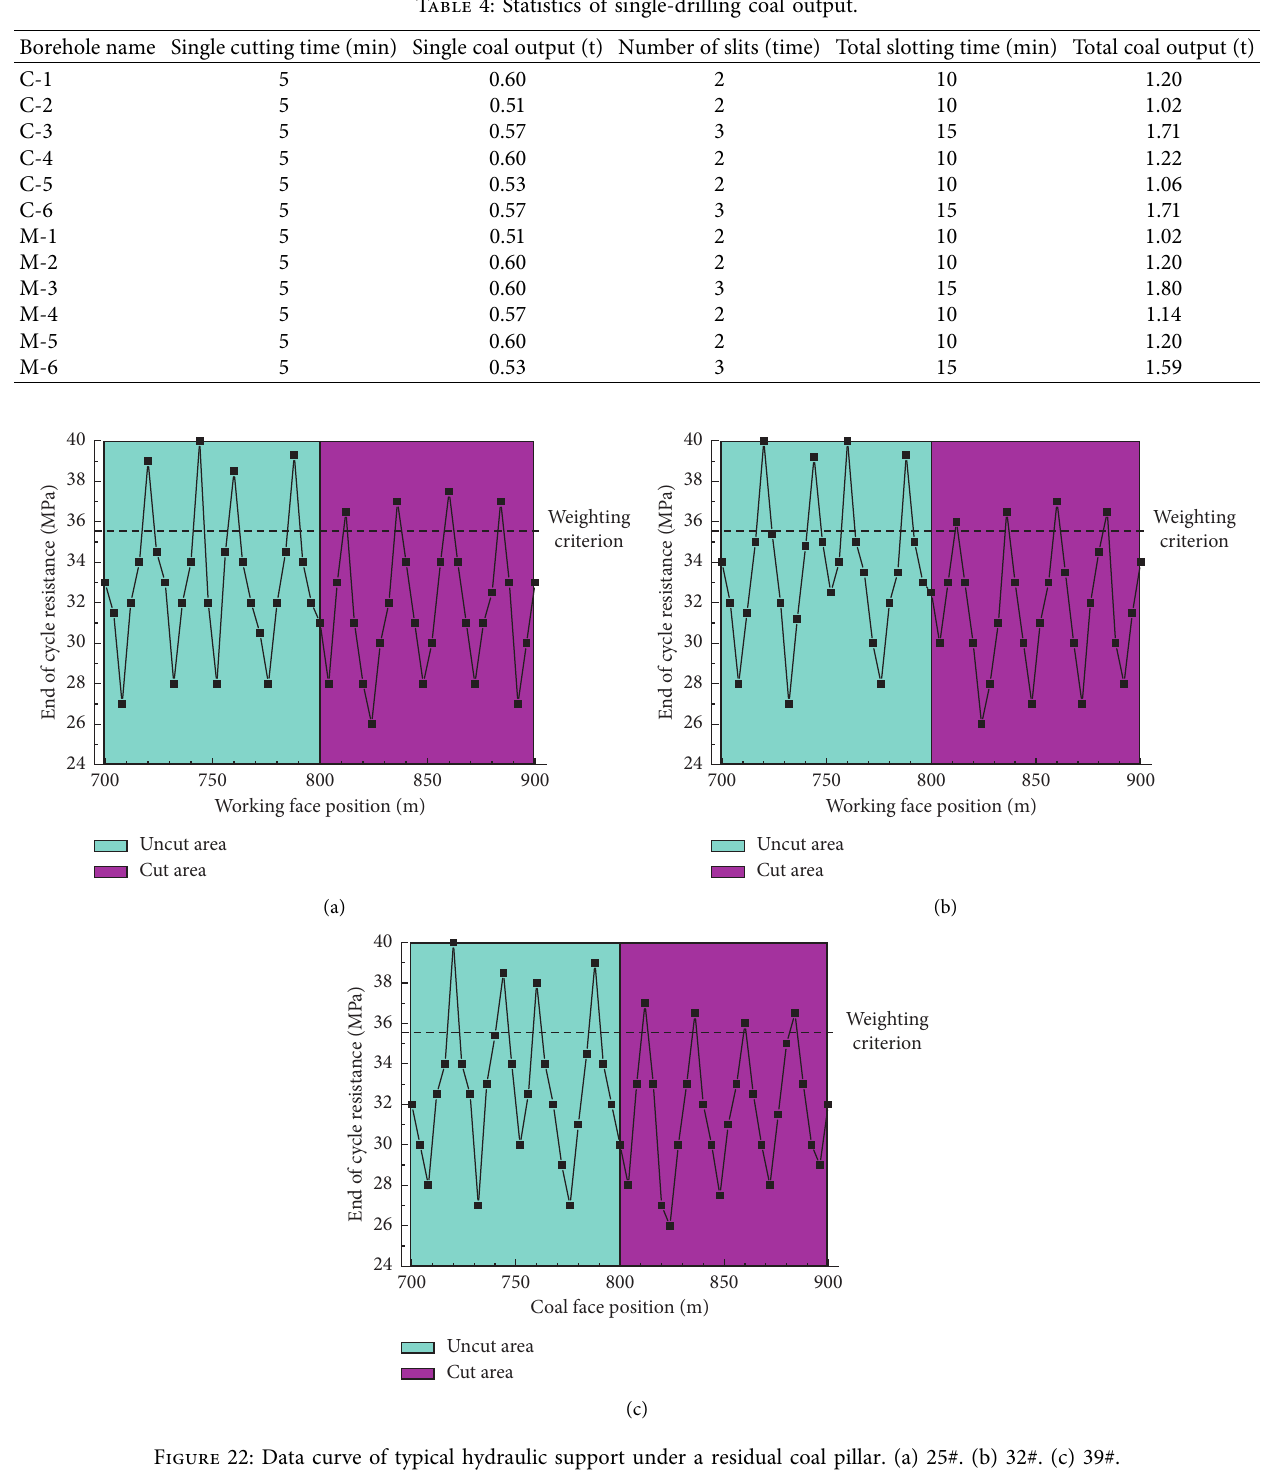
Table 4: Statistics of single-drilling coal output.